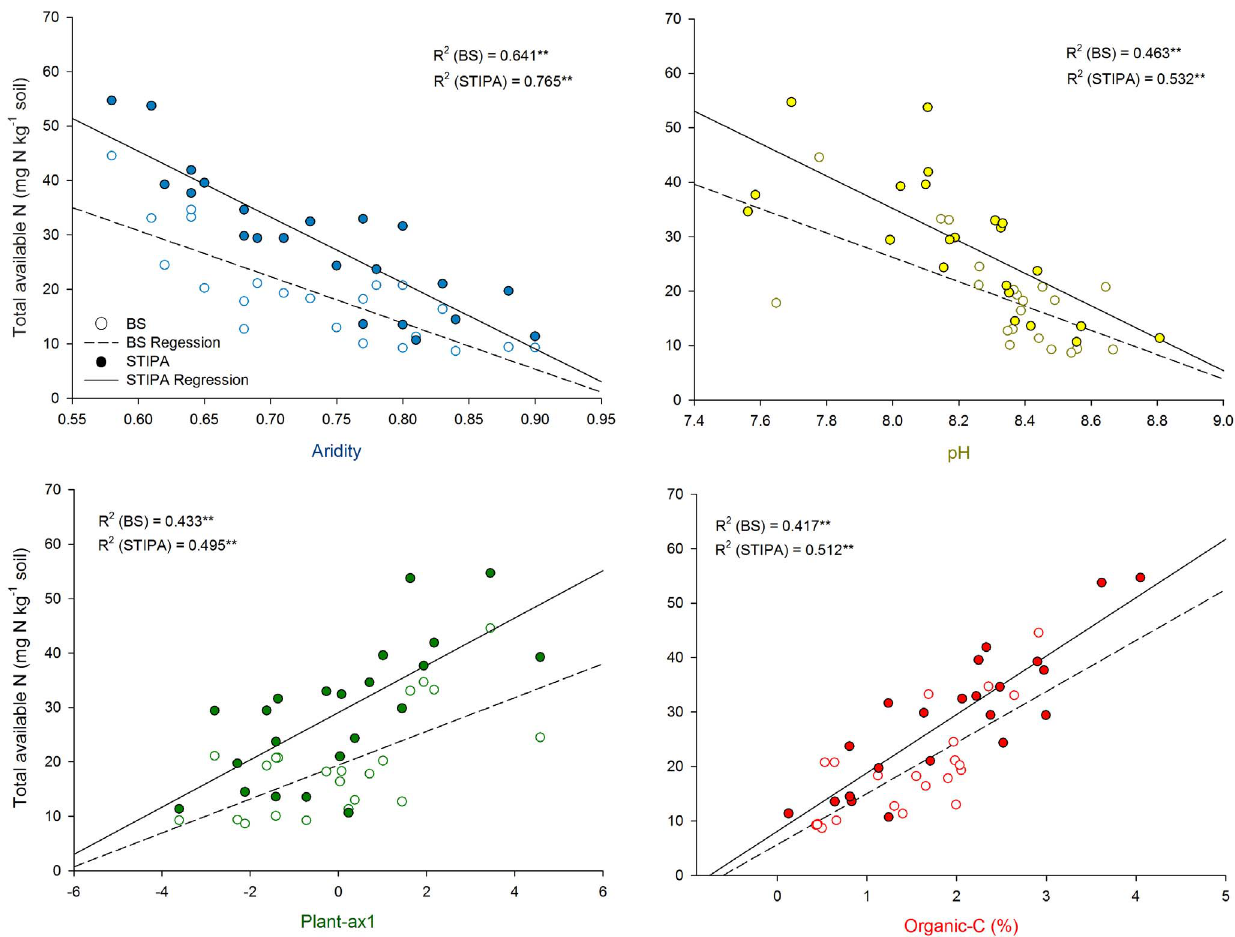
Figure 1. Relationships between total nitrogen (N) availability and aridity, pH, plant-ax1 (first component of a PCA including the cover of bare and plant microsites, average plant patch interdistance, area of plant patches and number of plant patches per 10 m of transect) and organic carbon for both Stipatenassicima (STIPA) and Bare ground (BS) microsites. Every data point is the average of five replicated soil samples. Significance levels are as follows: *p , 0.05, **p , 0.01 and ***p , 0.001.